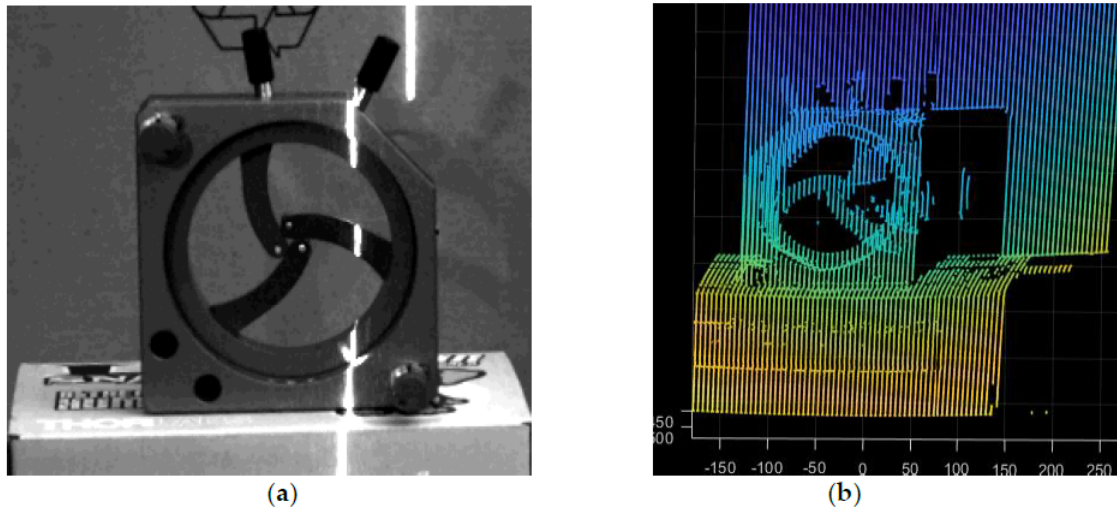
Figure 7. Three-dimensional (3D) reconstruction point cloud in air. ( a ) Measured object in the air; ( b ) Point cloud of